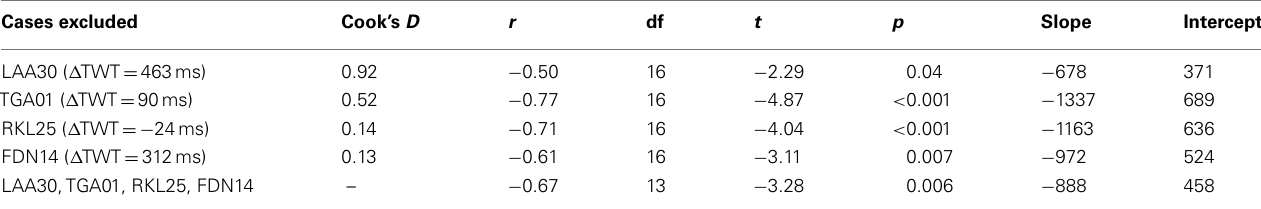
Table 1 | Robustness of results with elimination of